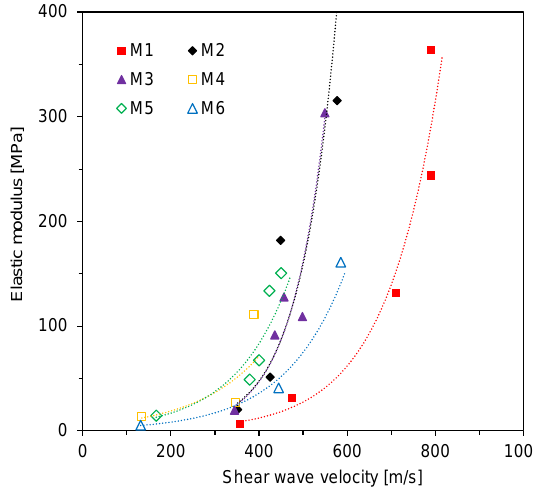
Figure 10. Elastic modulus versus shear wave velocity.